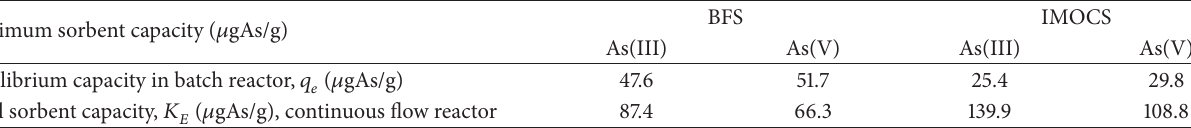
Table 6: Maximum sorbent capacity at 𝐶 𝑜 = 0.5 mg/L in batch and continuous flow